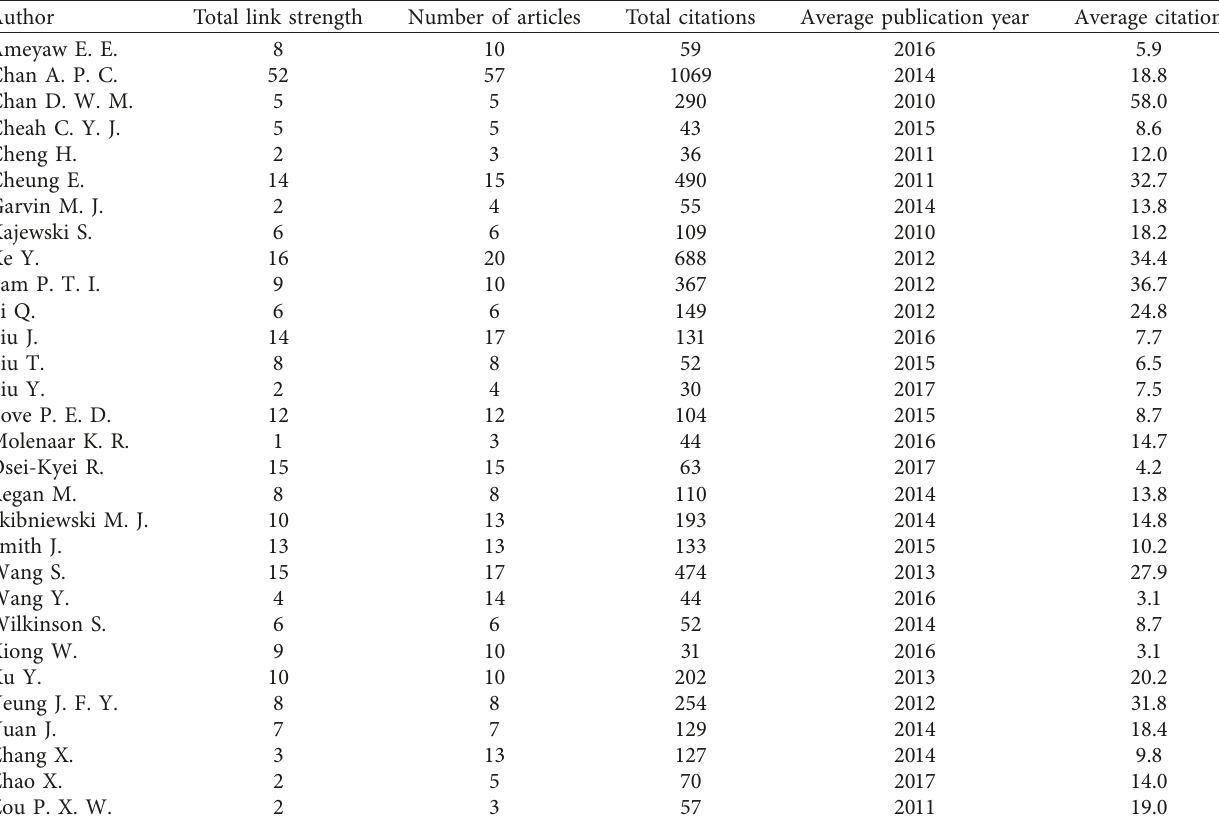
Table 3: List of active scholars in PPP research.